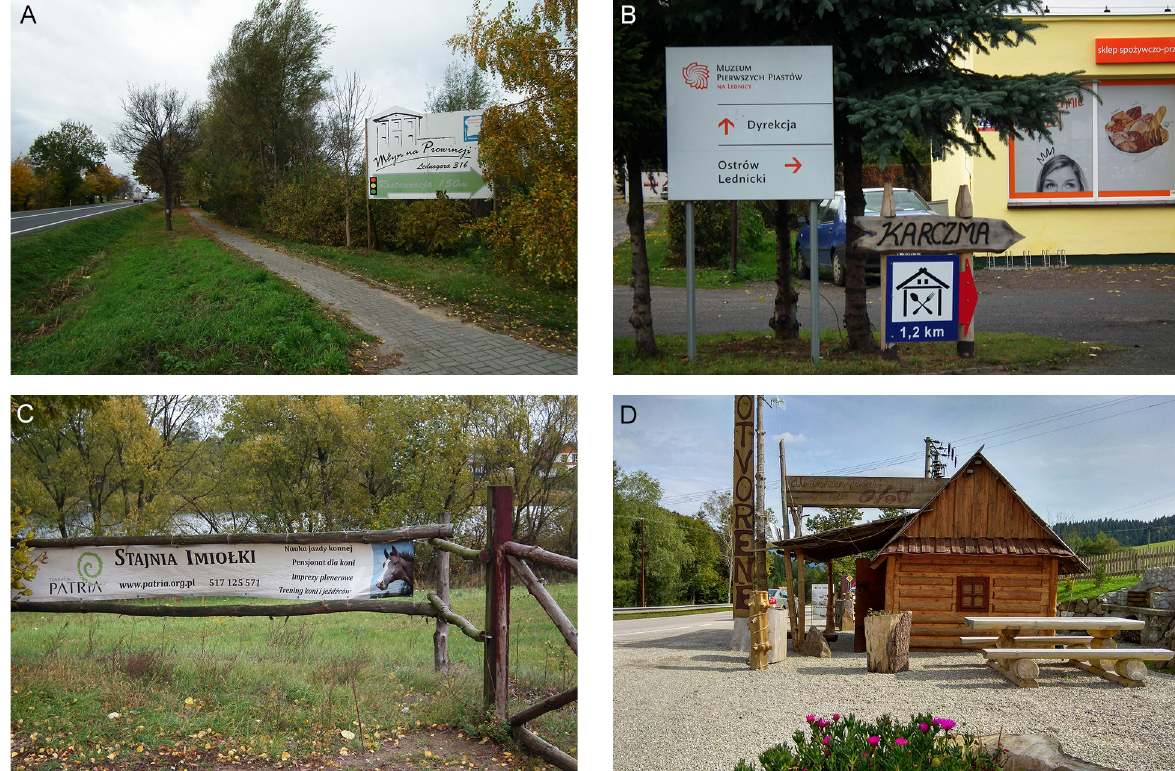
Fig. 5. Examples of good practice in the placement of advertisement carriers in relation to a landscape: A – a favourable selection of the location and the color and size of the advertising device in relation to the environment; B – a good example of an integrated/systemic advertisement; C – harmonious combination of an advertisement and fencing; D – harmonious adjustment of a location, shape and material of an advertising medium to a service and commercial